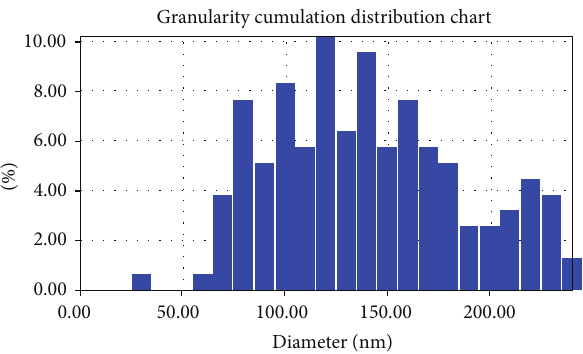
Figure 6: Granularity cumulation distribution chart of